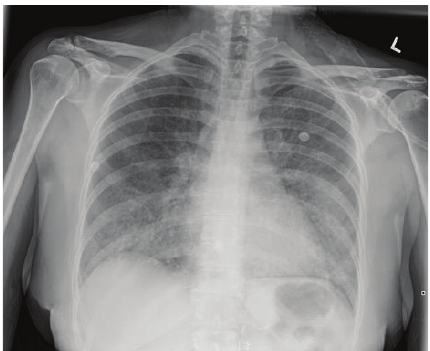
Figure 1: Initial chest radiograph, posterior-anterior view, showing hazy airspace opacification of the lower lobes bilaterally.